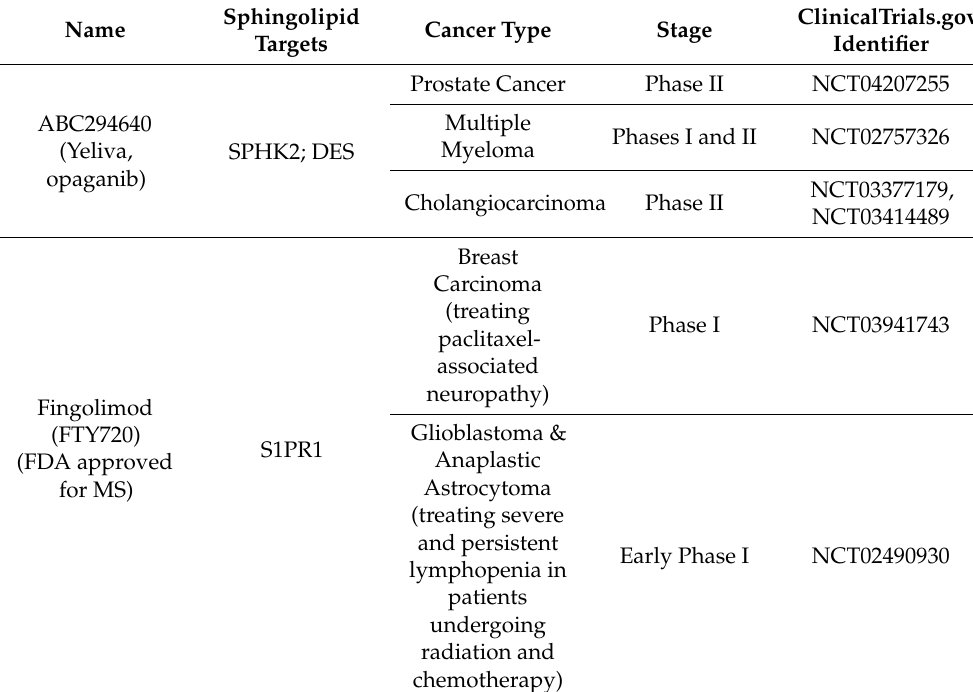
Table 2. Clinical trial drugs targeting sphingolipid metabolism for cancer